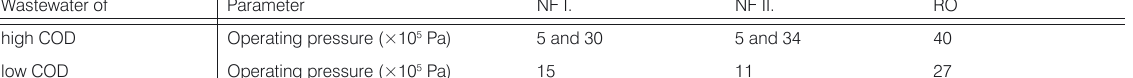
Permeate fluxes of nanofiltration membranes